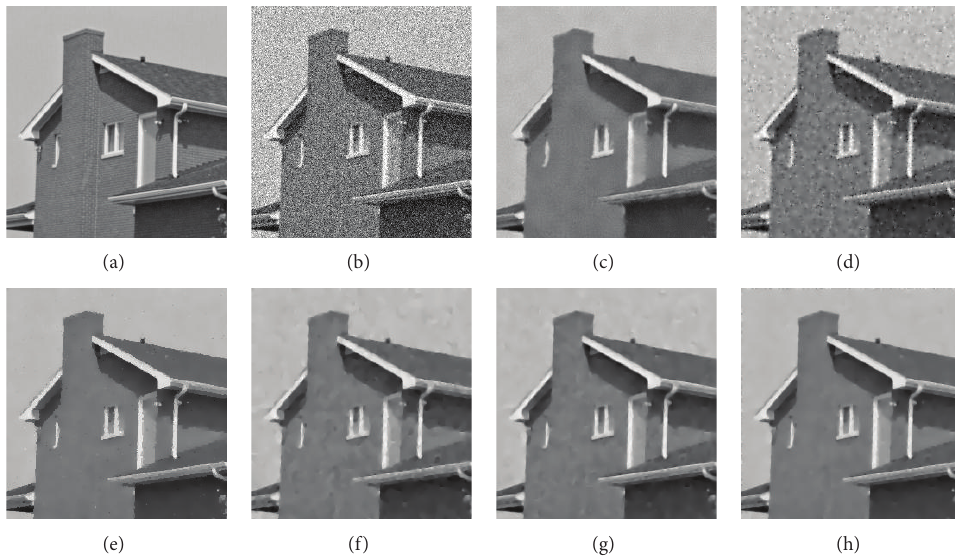
Figure 5: Results of the house image by the five models: (a) original image, (b) noisy image, (c) result by NLM, (d) result by Y-K model, (e) result by PM, (f) result by TV, (g) result by MTV, and (h) result by our model.